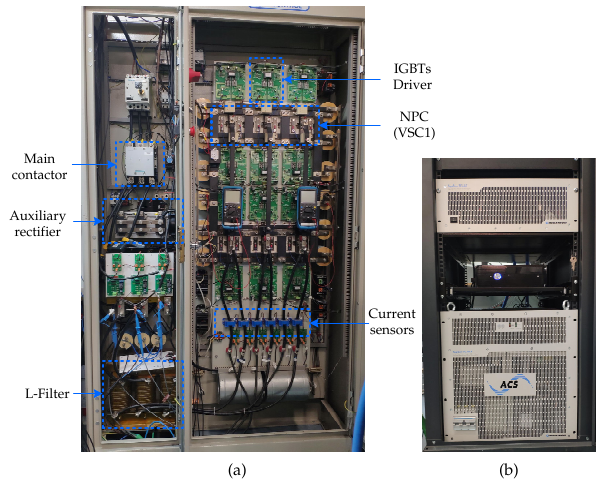
Figure 9. Experimental setup: ( a ) NPC power converter. ( b ) Regatron Topcon Quadro programmable power